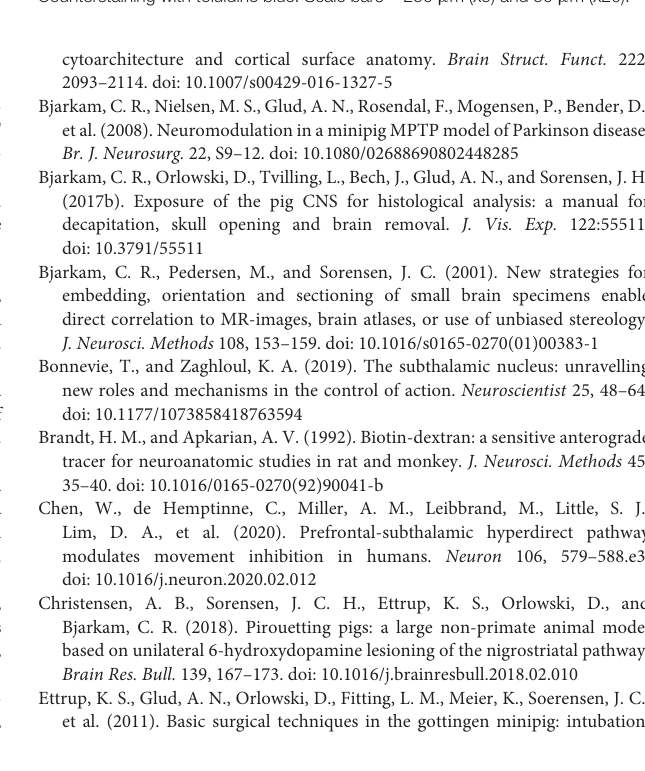
M1 and dPFC, respectively, marked with arrowheads. Counterstaining with toluidine blue. Scale bars = 5 mm. SUPPLEMENTARY FIGURE 2 | Neuronal tracing with BDA in JBG-1. The figure depicts an absence of motor projections from the primary motor cortex (M1) to areas of the medial subthalamic nucleus, STN (dashed lines). The three rows display the anterior, central, and posterior segment, respectively, which is depicted in x1.25 magnification for overview in the left column. Colored miniature windows are the areas seen in detailed x20 magnification in the right column, where no traced fibers are seen in the medial STN. Only sparse motor projections where found elsewhere in the medial STN. ZI, zona incerta; cp, cerebral peduncle; Th, thalamus; SNc, substantia nigra pars compacta. Counterstaining with toluidine blue. Scale bars = 1 mm (x1.25) and 50 µ m (x20). SUPPLEMENTARY FIGURE 3 | Neuronal tracing with BDA in JBG-2. The figure shows an absence of associative projections from the dorsal prefrontal cortex (dPFC) to areas of the lateral subthalamic nucleus, STN (dashed lines). The three rows display the anterior, central, and posterior segment, respectively, which is depicted in x1.25 magnification for overview in the left column. Colored miniature windows are the areas seen in detailed x20 magnification in the right column, where no traced fibers are seen in the lateral STN. Only sparse associative projections where found elsewhere in the lateral STN. ZI, zona incerta; cp, cerebral peduncle; Th, thalamus; SNc, substantia nigra pars compacta. Counterstaining with toluidine blue. Scale bars = 1 mm (x1.25) and 50 µ m (x20). SUPPLEMENTARY FIGURE 4 | Neuronal tracing in nucleus accumbens, NAcc, in the upper row, and in septum, Sep, in the lower row. The left overview column is shown in x1.25 magnification marked with a colored miniature window, which is then shown in x20 magnification in the right column. BDA labeled axons are golden-brown and marked with arrowheads. LVa, lateral ventricle anterior part. Counterstaining with toluidine blue. Scale bars = 1mm (x1.25) and 50 µ m (x20). SUPPLEMENTARY FIGURE 5 | Neuronal tracing in the ventral prefrontal cortex, vPFC. The left overview image is shown in x5 magnification marked with a colored miniature window, which is then shown in x20 magnification in the right image. BDA labeled axons are golden-brown and marked with arrowheads. Counterstaining with toluidine blue. Scale bars = 250 µ m (x5) and 50 µ m